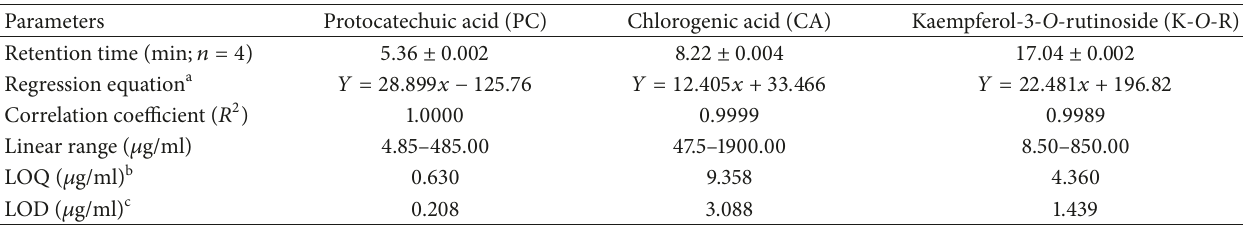
Table 1: Method validation parameters for quantitation of protocatechuic acid, chlorogenic acid, and kaempferol-3- O -rutinoside.